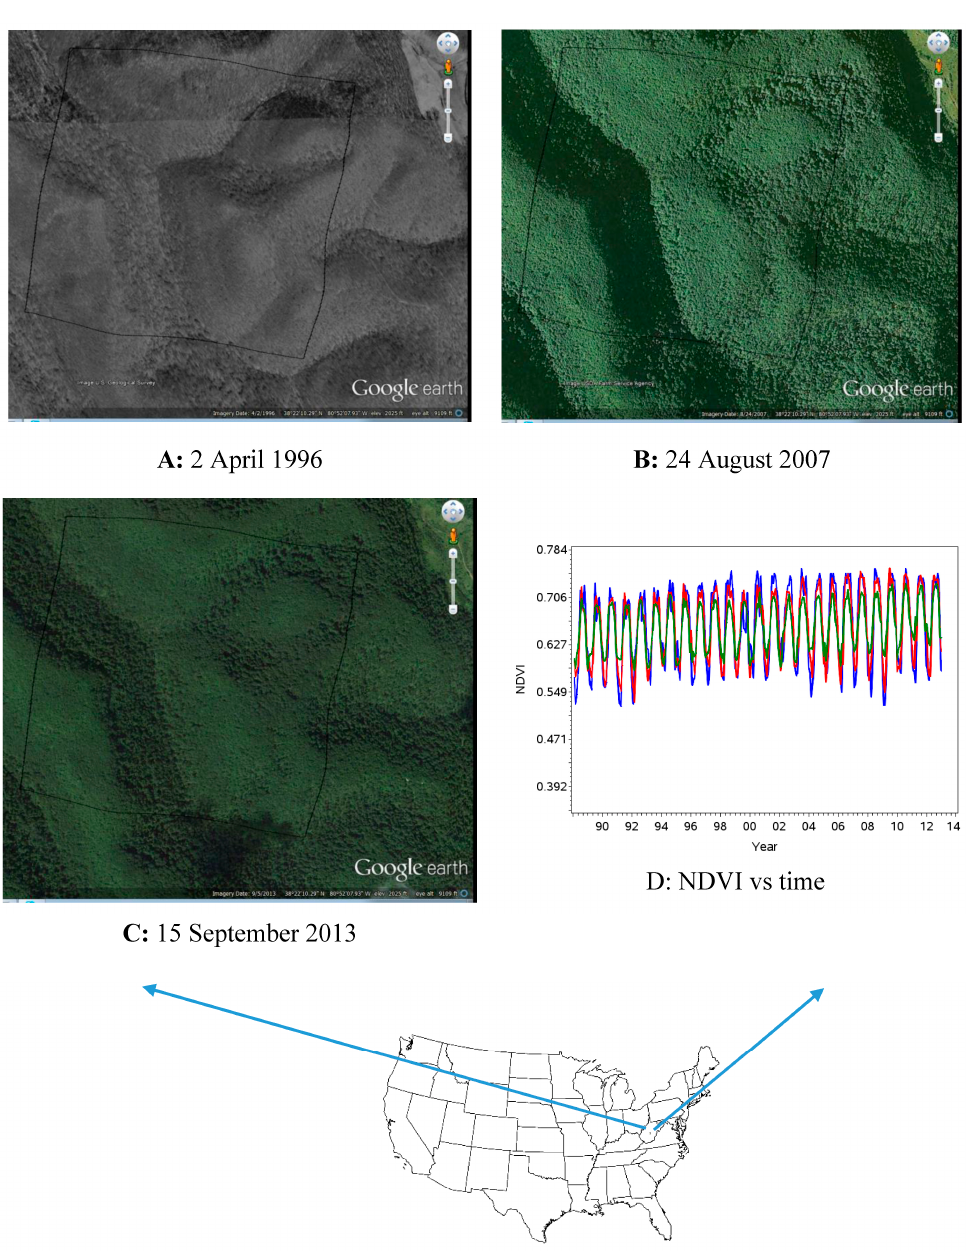
Figure 8. Forested land located in central West Virginia that had a significantly increasing NDVI trend without discernable land cover change (Outcome B). The latitude and longitude of the pixel center is 38°22 ′ 11 ″ N and 81°51 ′ 56 ″ W. ( A – C ) Google Earth TM images indicating no change in land cover between 1996 and 2013; and ( D ) NDVI with time (NDVI trend increased significantly in univariate ( p < 0.0001) but it was not significant after including the climatic factor ( p = 0.0663) (lines are described in Figure S2).